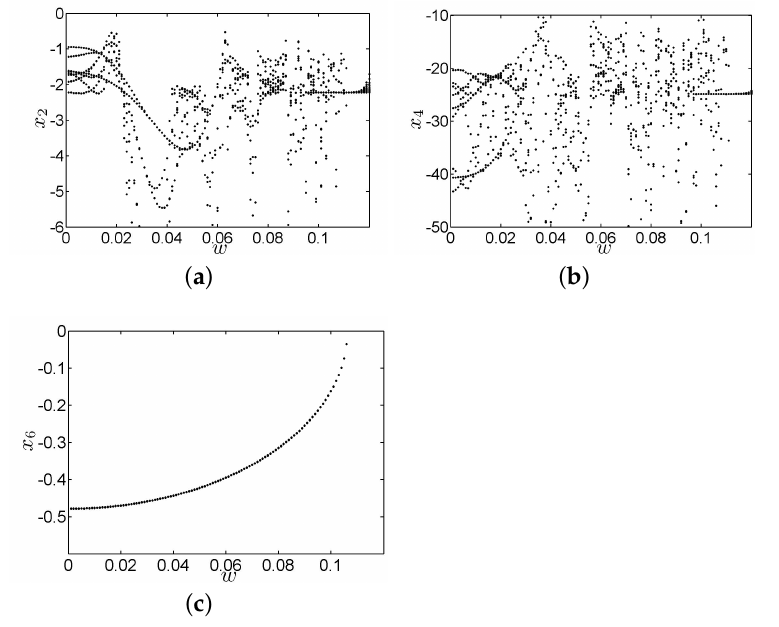
Figure 4. The bifurcation diagram with different angular velocities. ( a ) The axial bifurcation. ( b ) the torsional bifurcation. ( c ) the lateral